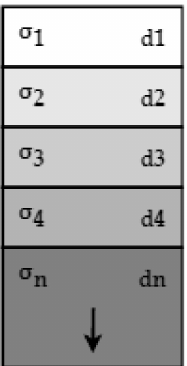
Figure 1. One-dimensional (1-D) layered earth conductivity model reproduced with permission from [4], NERC,